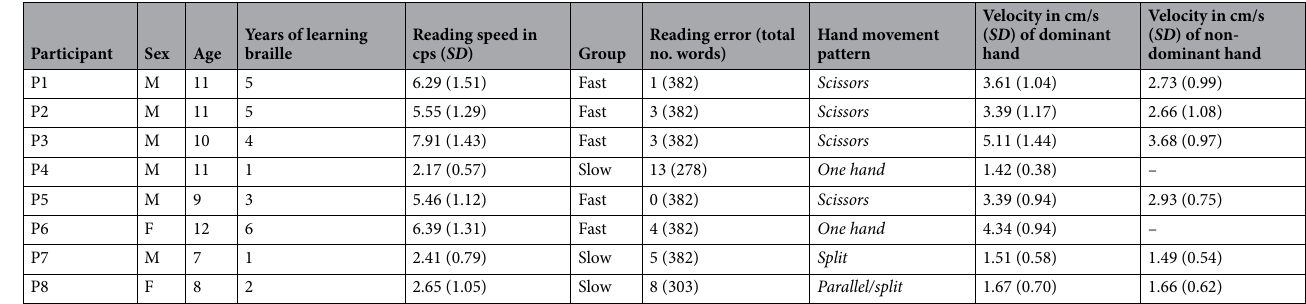
Table 2. Characteristics of individual participants and their braille reading performance. Age refers to each participant’s age at the beginning of study. Hand movement pattern of P8 was observed to have changed from “parallel” to “split” from the third recording session (October, 2019). Total number of words read by P4 and P8 was small compared to other participants for the following reasons: P4 was unable to read braille sentences at the first recording. P8 read only few lines of the text in the first and second session, which she read only once without repetition. The velocity of the reading finger of the non-dominant hand is shown for